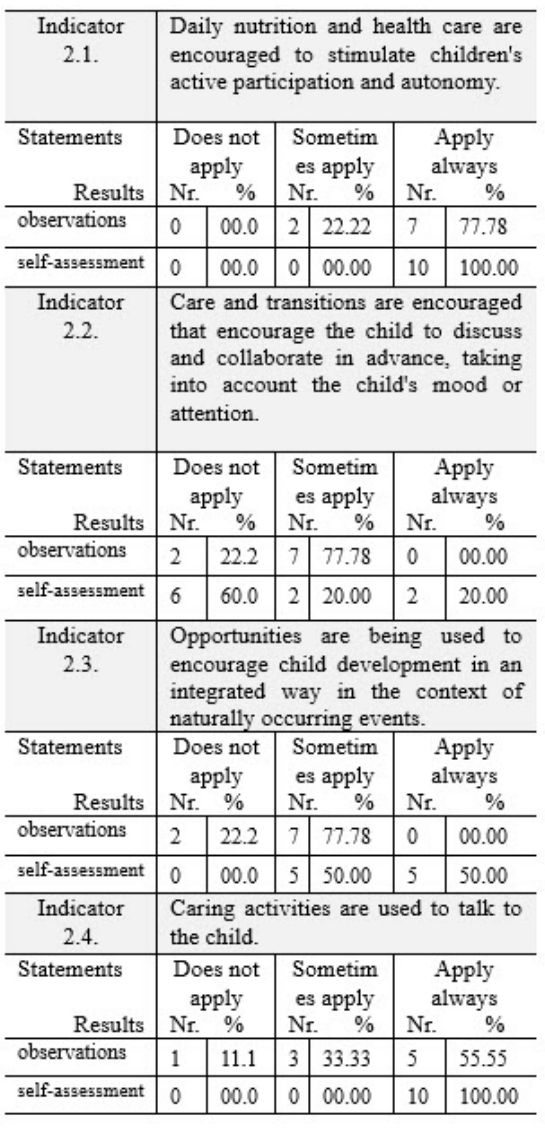
Table 19. Principle 2: Care is seen as an opportunity for development and